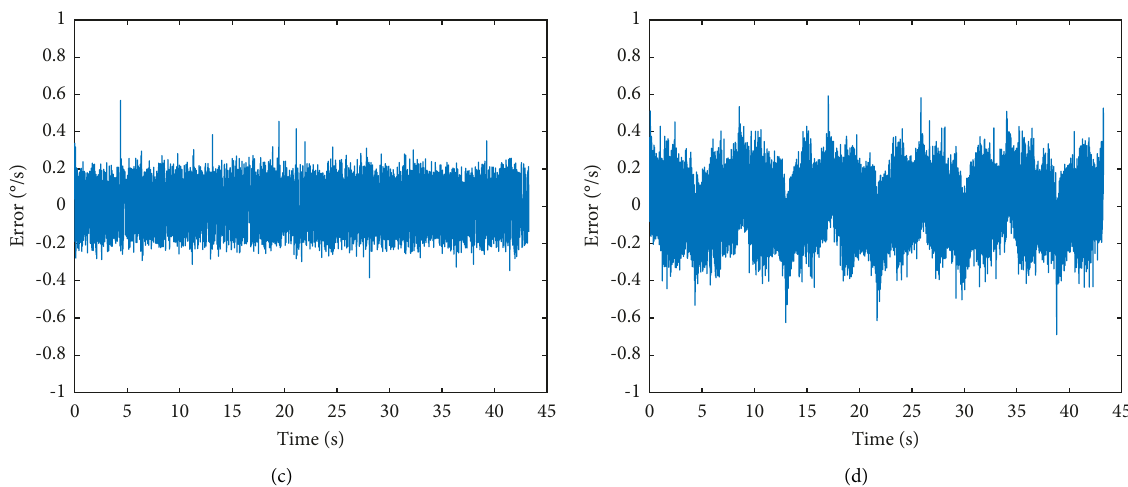
Figure 5: Simulation results under 30 ° /s. (a) Elbow joint torque. (b) Comparison between reference speed, speed response of the FOFPID controller, and speed response of the PID controller. (c) Error between reference speed and speed response of the FOFPID controller. (d) Error between reference speed and speed response of the PID